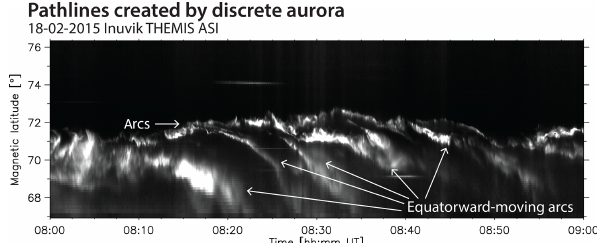
Figure 3. An example of equatorward arcs creating multiple path- lines that move in the same direction. These images were captured by the THEMIS ASI stationed in Inuvik, Nunavut, on 18 Febru- ary